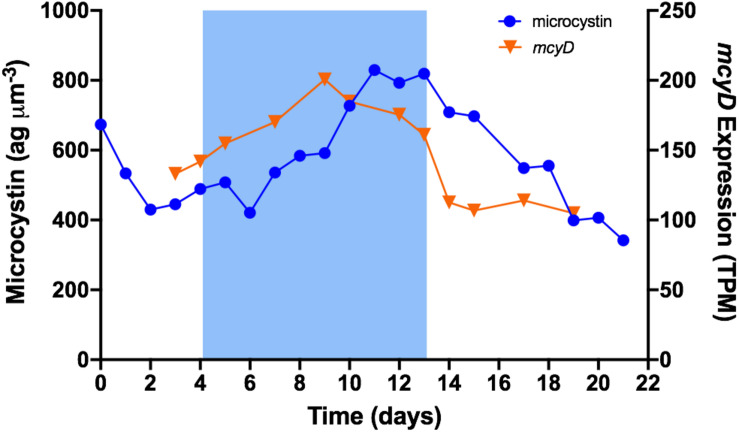
Time trace of mcyD expression and normalized cellular microcystin content. Blue shading represents time period when temperature was set to 19°C.